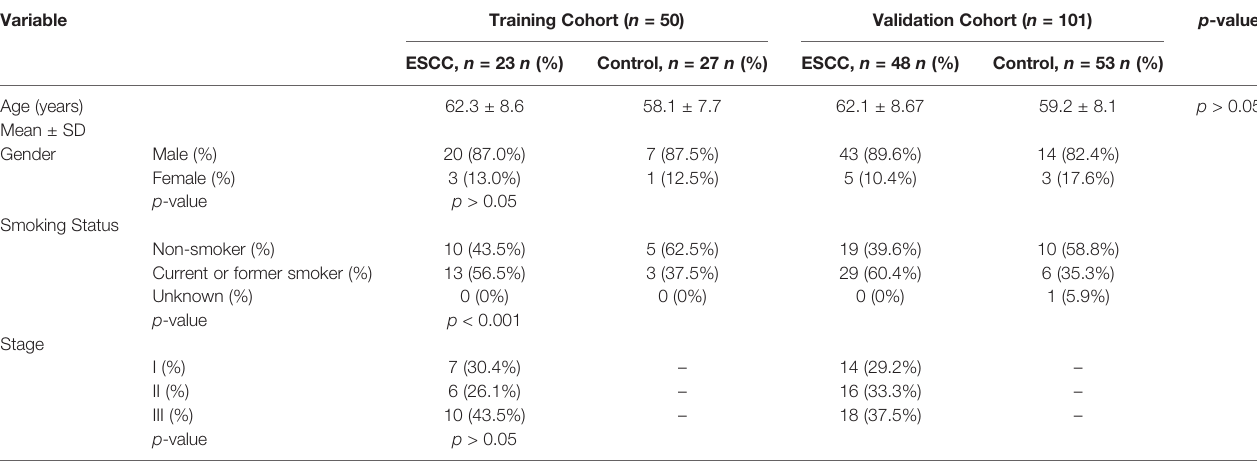
TABLE 1 | Characteristics of participants in the training cohort and validation